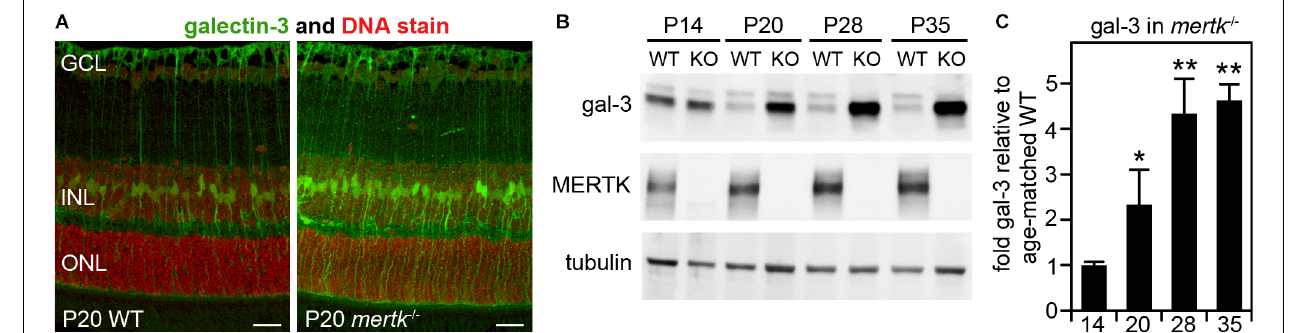
FIGURE 2 | Galectin-3 levels are increased in MERTK-deficient retina as early as P20. Tissues of age-matched WT and mertk -/- mice obtained at P20 (A) or at ages from P14 to P35 as indicated (B) were dissected to yield either embedded samples for sectioning, and subsequent galectin-3 immunofluorescence microscopy (A) , or isolated neural retina for immunoblotting (B,C) . Representative image panels in (A) show galectin-3 (green) and nuclei counterstain (red) in WT (left panel) and mertk -/- (right panel) mouse retina cross sections. Retinal layers are marked as follows: GCL, ganglion cell layer; INL, inner nuclear layer; ONL, outer nuclear layer. Scale bars: 20 µ m. Representative immunoblots in (B) with probes as indicated were quantified to yield differences in galectin-3 levels, which are plotted in (C) . Bars show mean ± s. d.; n = 3 biological samples from three different mice. Data were analyzed by ANOVA; * indicates p < 0.05, ** indicates p < 0.01.